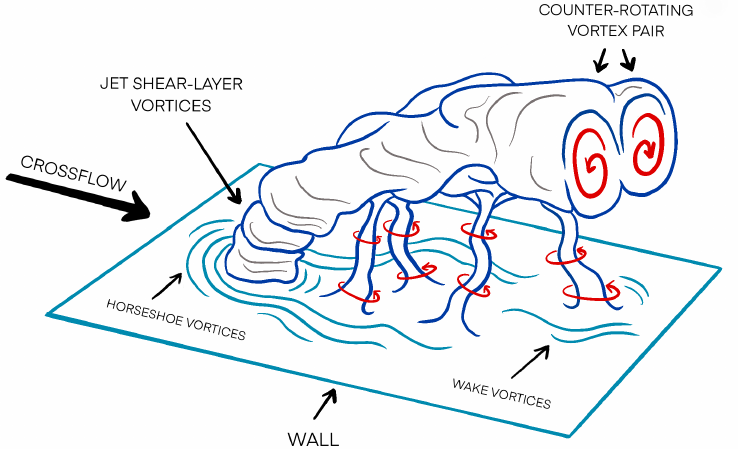
Figure 1. Schematic of the different types of vortical structures in a crossflow jet. Adapted from